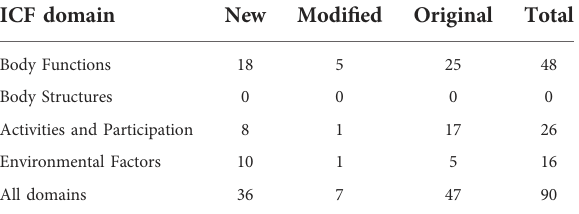
TABLE 2 The absolute number of new, modi fi ed or original items developed for each domain of the International Classi fi cation of Functioning, Disability and Health